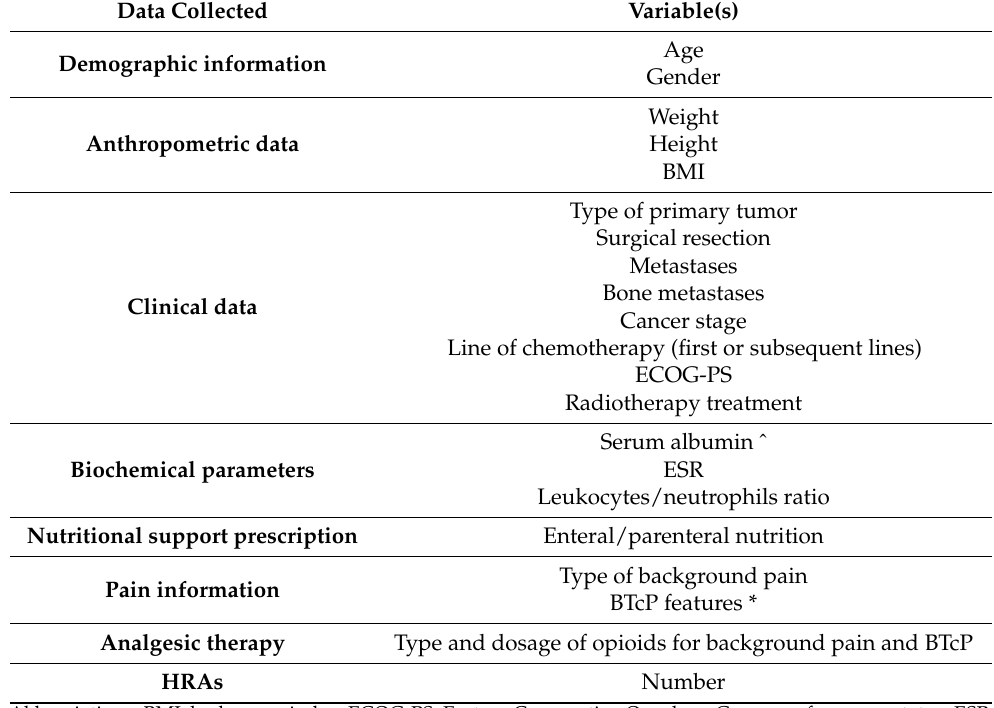
Table 1. Data collection and variables. Data